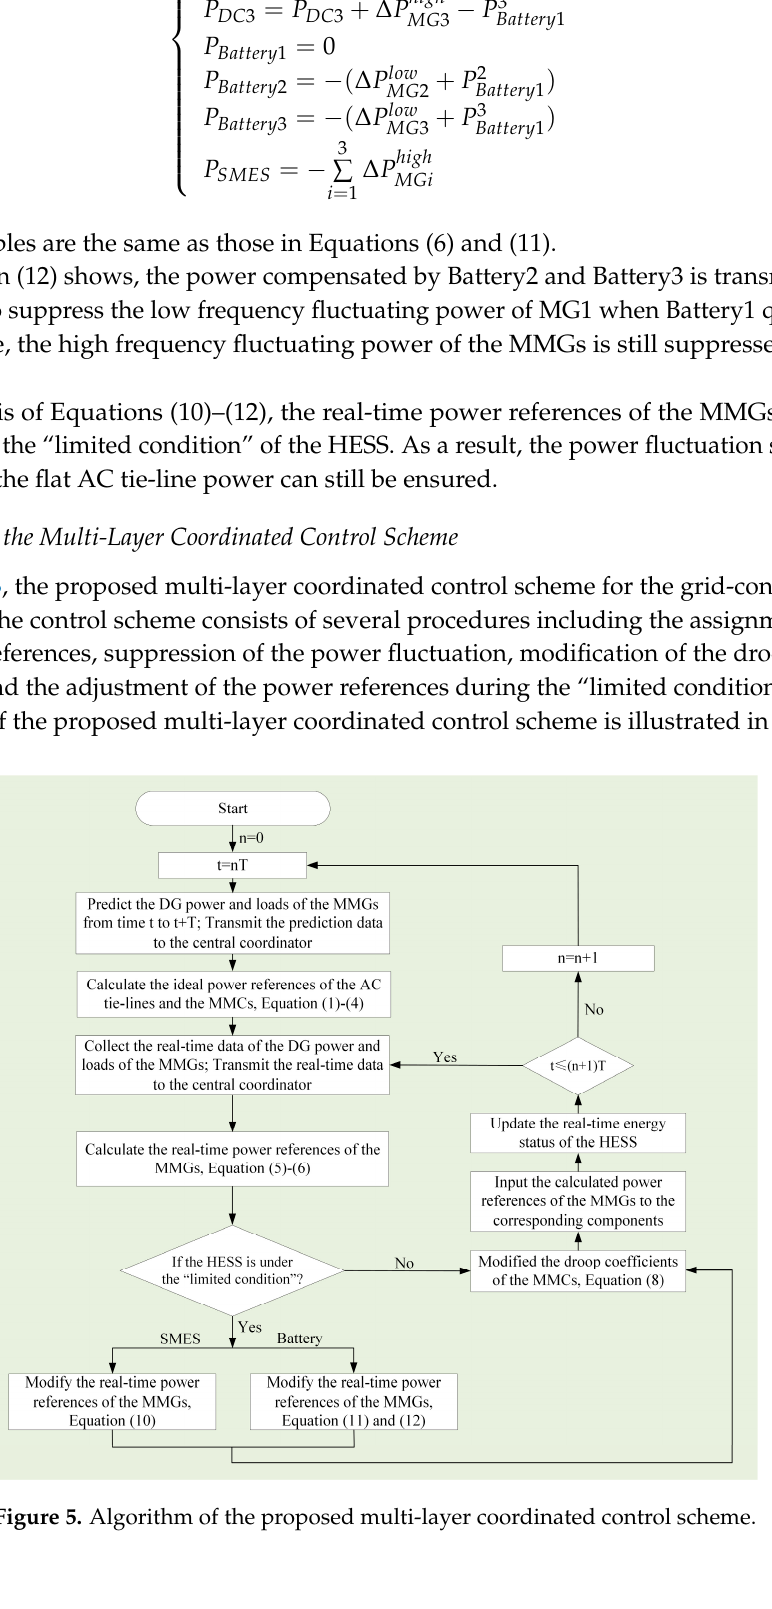
Table 2. Components of the sub-microgrids and their nominal active power. Sub-microgrids Components Nominal Power Sub-microgrids